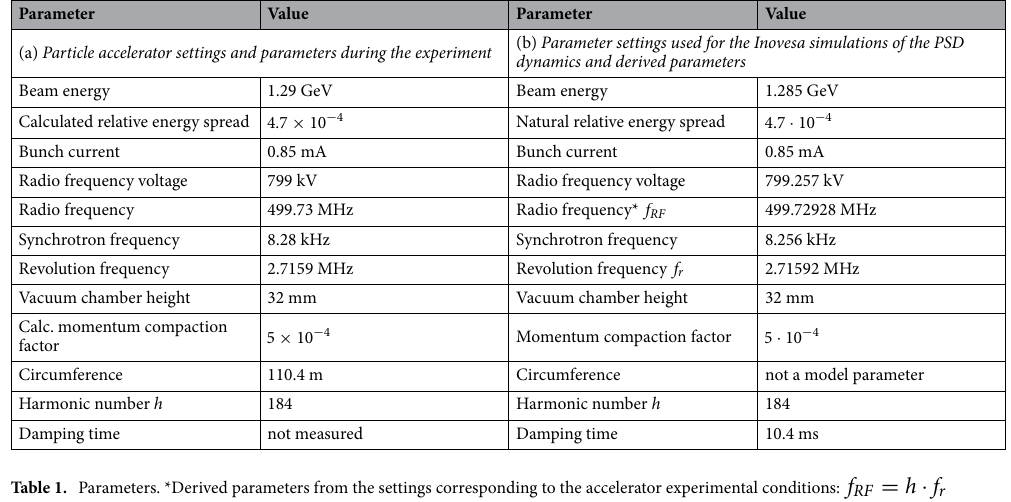
Table 1. Parameters. *Derived parameters from the settings corresponding to the accelerator experimental conditions: